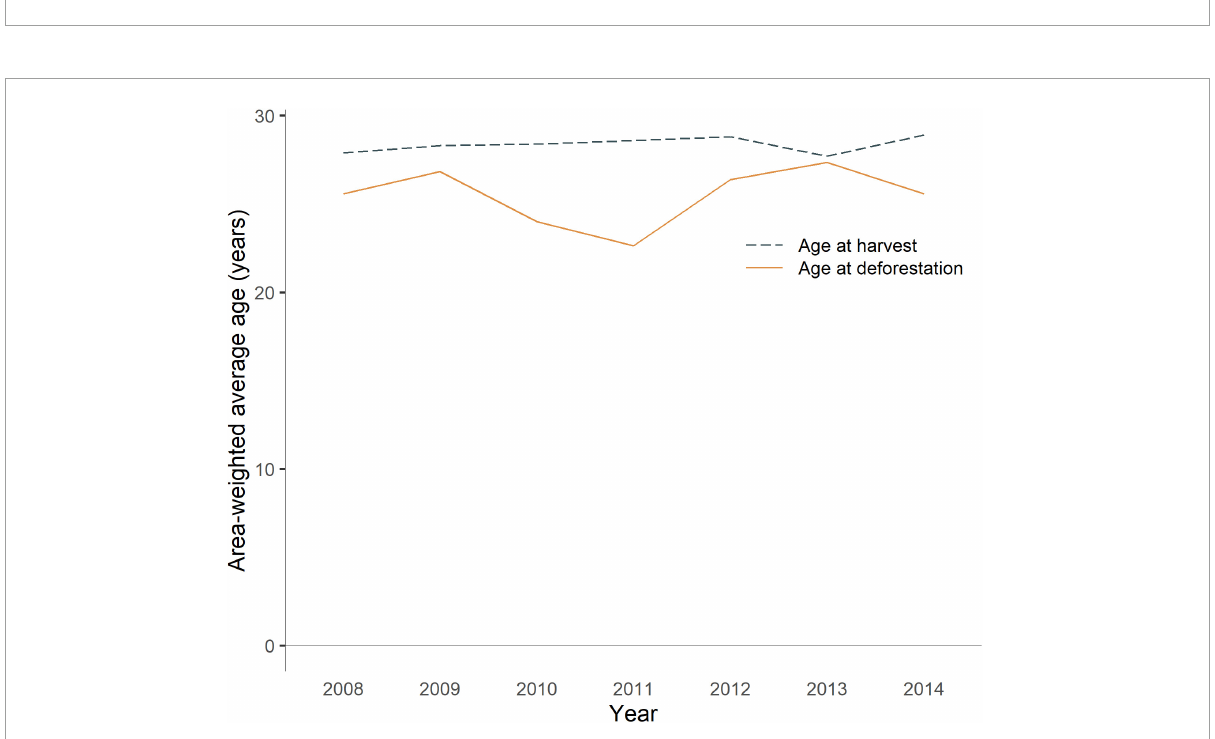
FIGURE7 Notified and observed annual deforestation along with the average annual NZU price for 2008–2020. Note that notified deforestation data are not available for 2019 and 2020. Data from EPA (2017, 2018), Jarden (2022), and MfE (2022a).